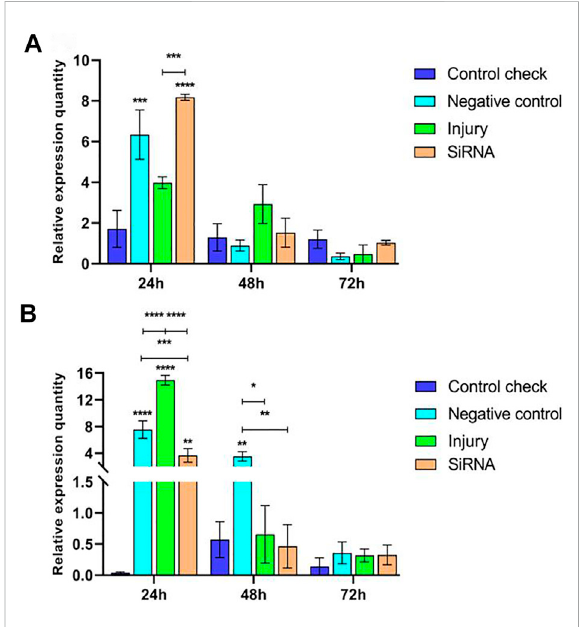
FIGURE 5 Effects of interfering target genes on Vitellogenin-2 gene expression in Z.cucurbitae (Coquillett). (A) Interfering target genes afterthe25 ° Ctreatmentfor1 h( F (3,24) =5.937, p =0.0035; F (2,24) = 51.31, p < 0.0001; F (6, 24) = 8.164, p < 0.0001). (B) Interfering target genes after the 45 ° C treatment for 1 h ( F (3, 24) = 43.28, p < 0.0001; F (2, 24) = 126.1, p < 0.0001; F (6, 24) = 38.32, p < 0.0001). All values in the fi gure are presented as mean ± standard error. *, **, ***, and **** above the histograms indicate the values that differ signi fi cantly between treatments p ≤ 0.05, p ≤ 0.01, p ≤ 0.001, and p ≤ 0.0001, respectively.